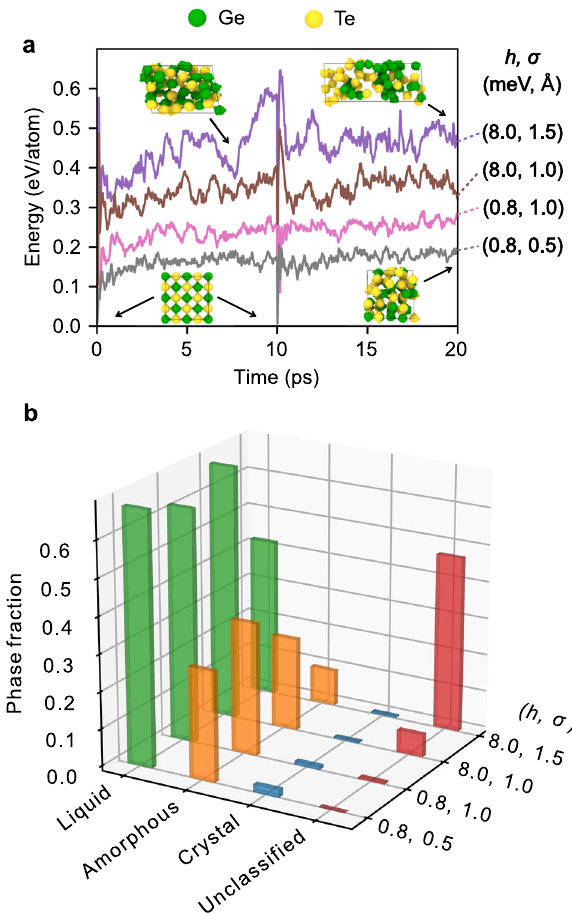
Fig. 3 Energy and fraction of phase in the four G-metaD. a Time evolution of potential energy of four G-metaD along the time. The energy is referenced to that of the rock-salt structure. Structures during G-metaD are shown as inset fi gures. b The phase fractions classi fi ed by Mahalanobis distances are shown for each ( h , σ